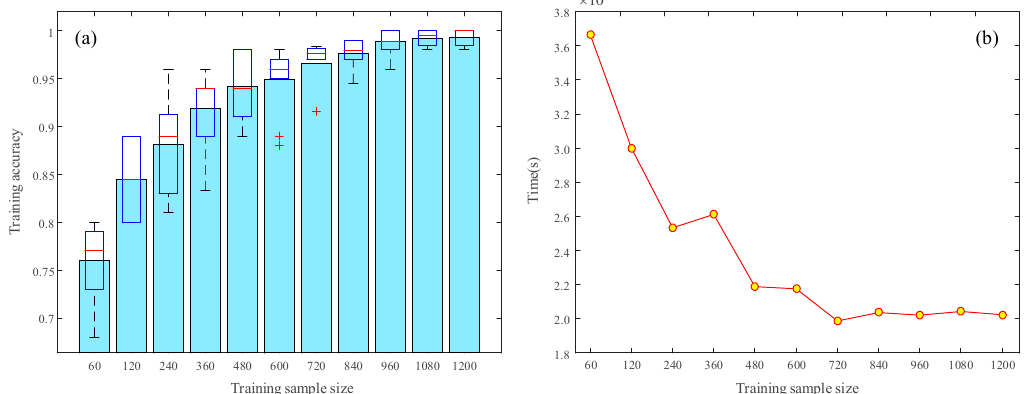
12 of 23 Table 5. Description of the sample distribution. IRF: inner race fault, ORF: outer race fault and BF: ball fault. Bearing Condition